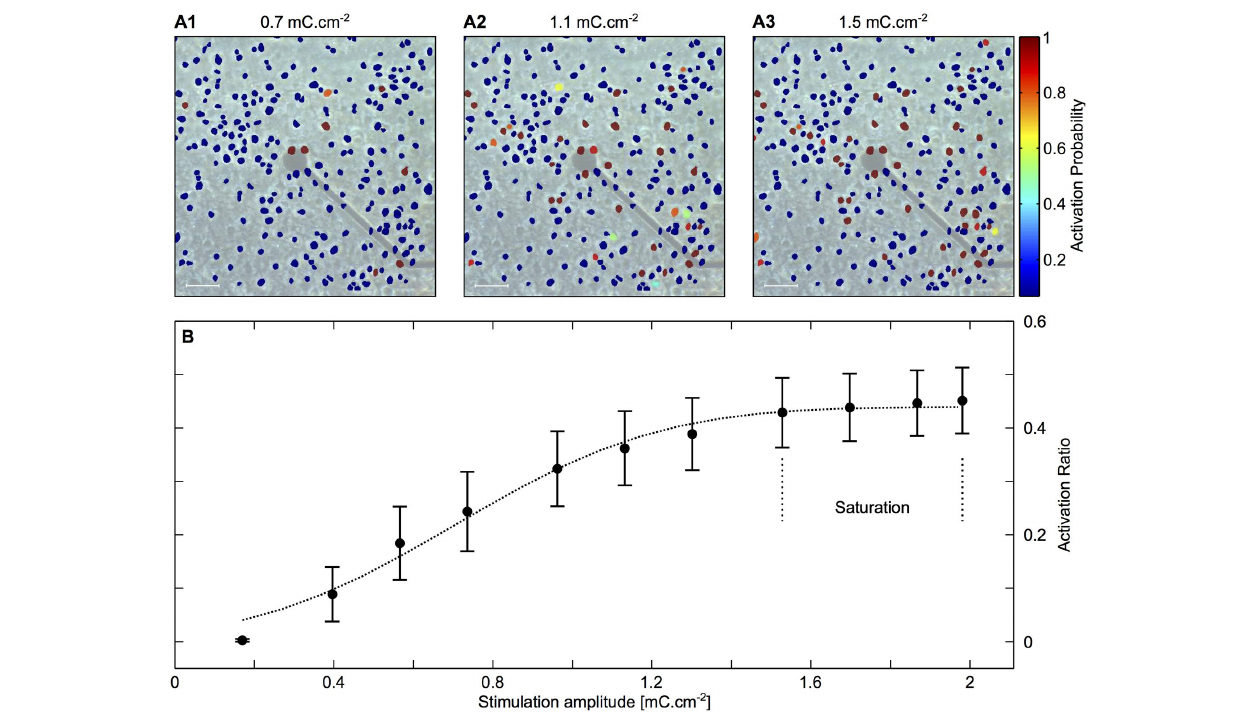
FIGURE 2 | Mapping activated neurons due to electrical stimulation amplitude and location. Cortical cultures were stimulated with rectangular and biphasic 400 µ s long current pulses of 25–35 µ A using MEA 30 µ m diameter electrodes. Neuronal action potentials evoked by an electrical stimulation were recorded and analyzed using Ca2 + imaging. (A1–A3) Color coded neuronal activation probability for three different stimulation amplitudes showing a correlation between stimulation amplitude and number of activated neurons. Scale bar: 50 µ m. (B) Illustration of the latter observation showing proportion of activated neurons as a function of stimulation amplitude. The results indicate a saturation zone at which no further neurons are activated due to the distance of the electrode. Adapted from Wallach et al. ( 56). Copyright 2014, Wallach et